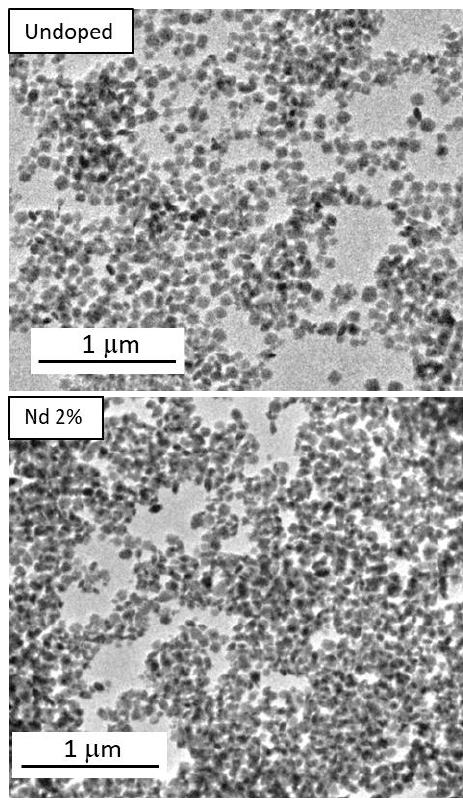
Figure 1. TEM images of the particles synthesized by precipitating solutions in EG/H 2 O (3.5/1.5) containing: ( top ) Na 3 VO 4 (0.04 mol dm − 3 ) and Lu(NO 3 ) 3 = 0.04 mol dm − 3 ; ( down ) under the same conditions but in the presence of 2% Nd (Nd/(Nd + Lu) mol ratio). In both cases, the aging temperature was set at 120 °C and aging time was 20 h.